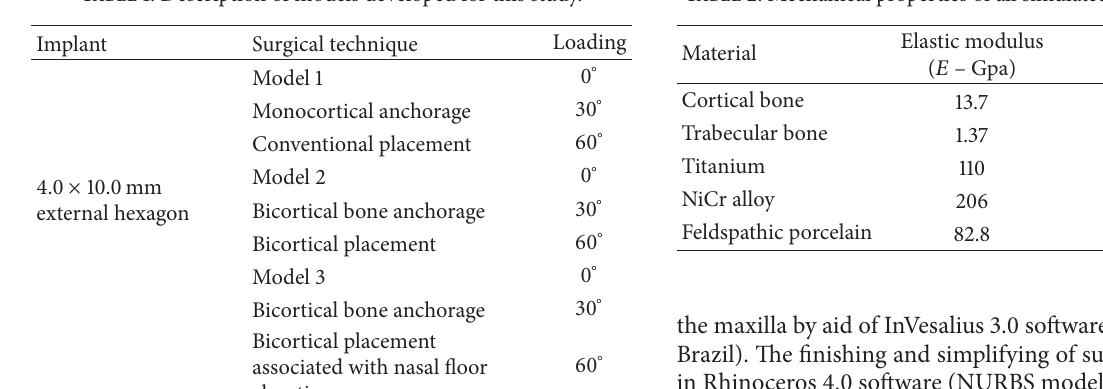
Table 2: Mechanical properties of all simulated materials [14,